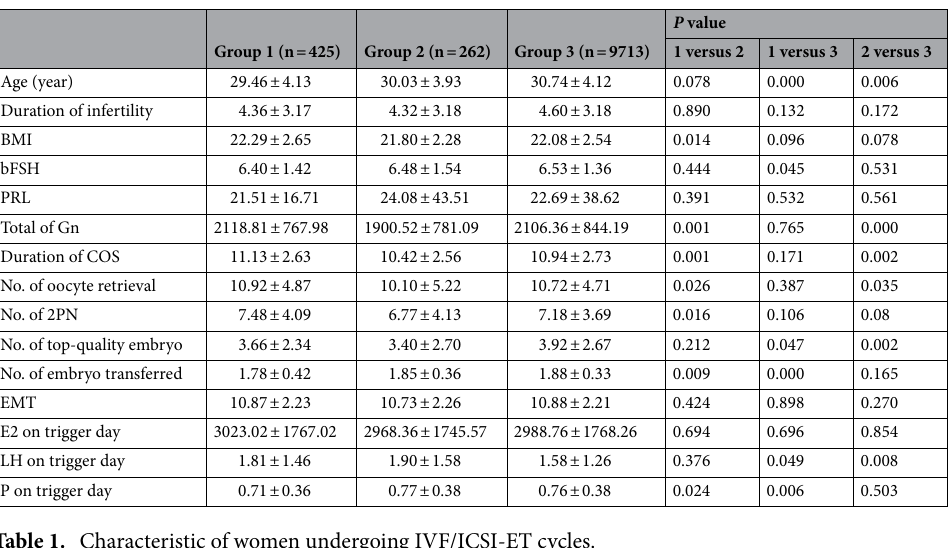
Table 1. Characteristic of women undergoing IVF/ICSI-ET cycles.